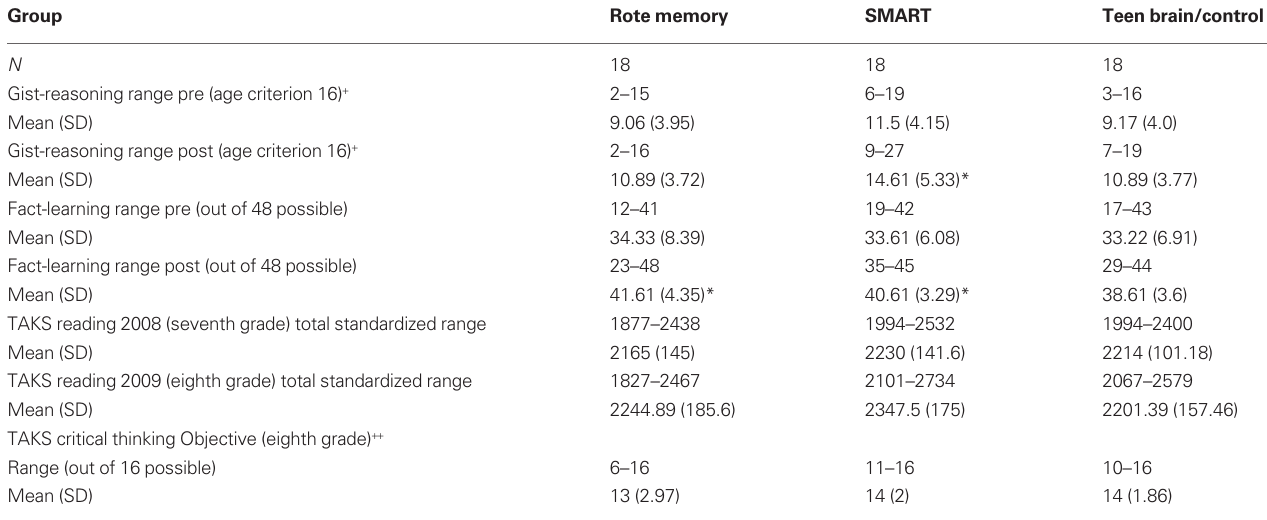
Table 2 | Baseline and post-training outcomes by